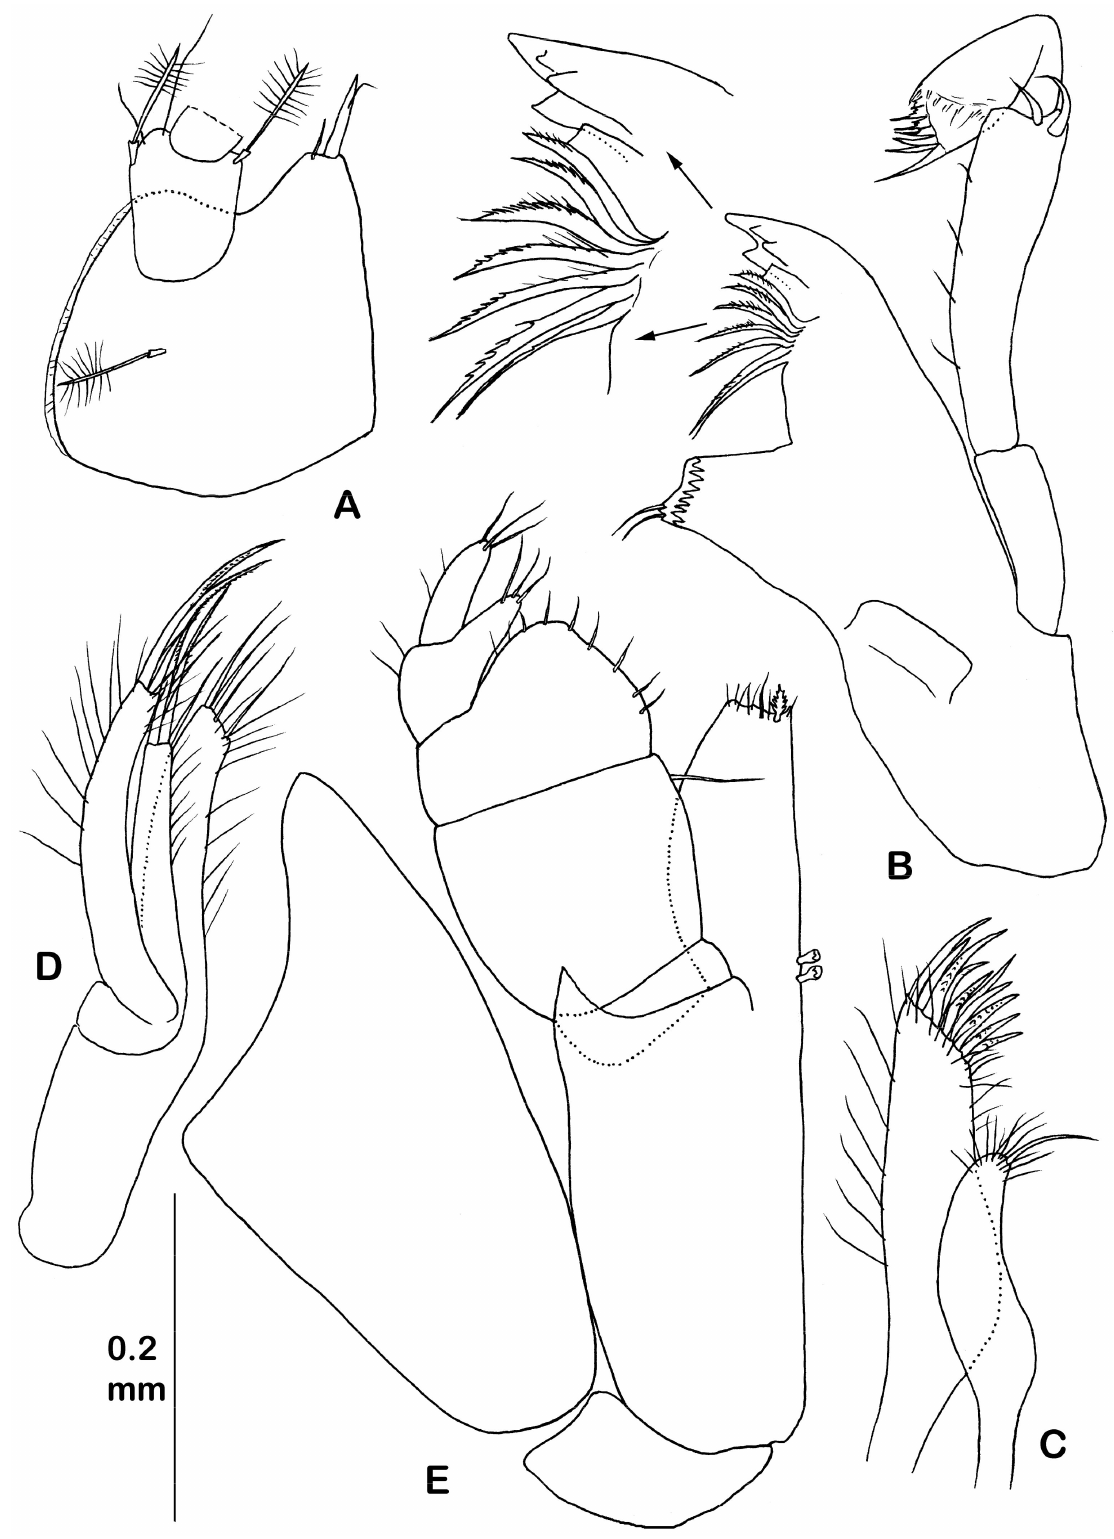
Figure 18. Eurycope nikitai sp. nov. Male paratype (ZMH K-45633): ( A ) antenna I, articles 1 and 2; ( B ) right mandible (incisor process enlarged); ( C ) maxilla I; ( D ) maxilla II; ( E ) maxilliped. Mandible (male paratype, ZMH K-45633, Figure 18B) incisors of right mandible with four cusps, spine row with eight spines, molar process with two small distal setae on